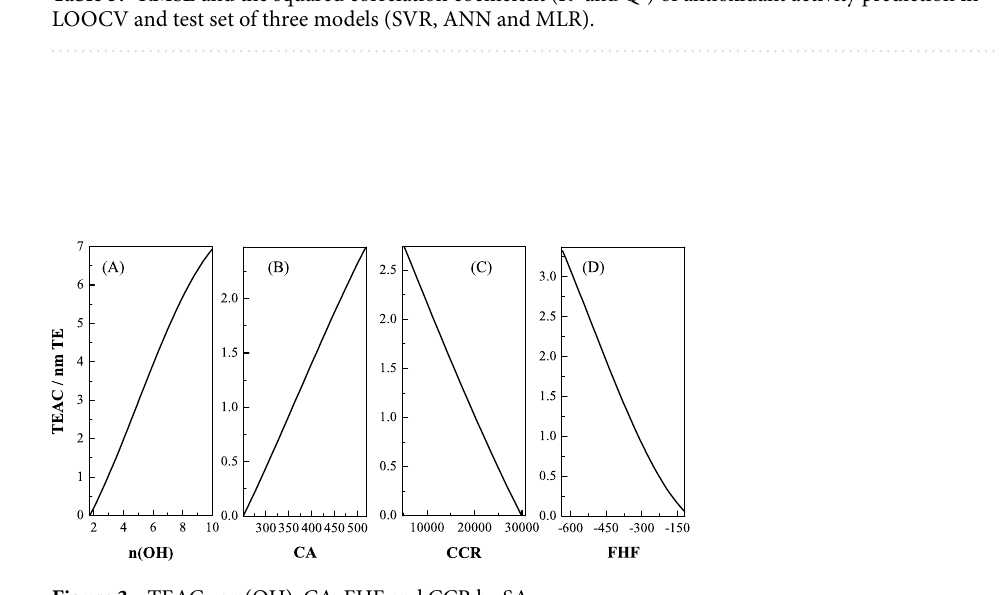
Figure 3. TEAC vs n(OH), CA, FHF and CCR by